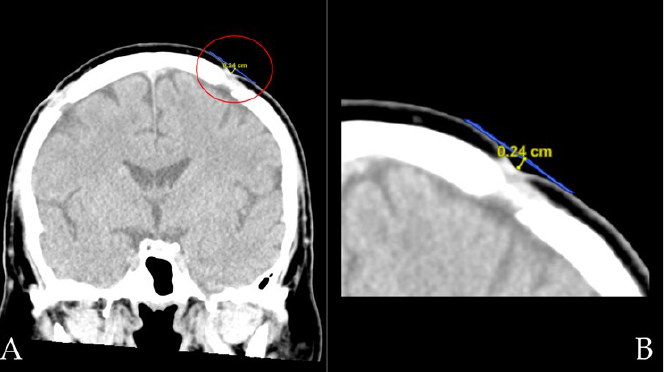
Figure 4. (A) A coronal CT image showing how radiological scalp depressions were measured, with an encircled scalp depression. (B) A magnified image of the scalp depression, to highlight how the distance was measured from the bottom of the depression to the hypothetical scalp line.